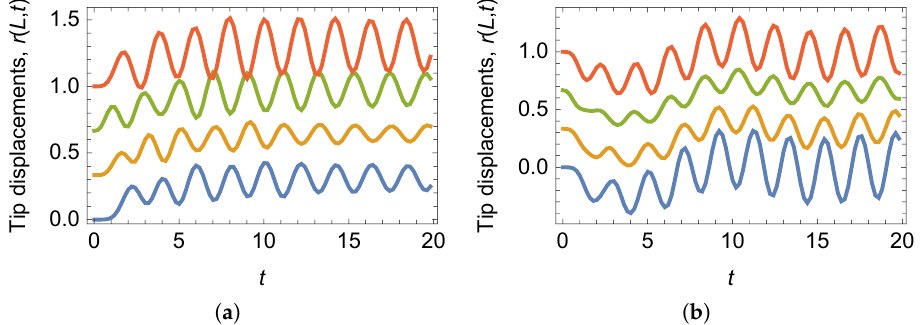
Figure 4. Evolution of the tip displacement: ( a ) rotation coupling and ( b ) curvature coupling. The response of the actuated filament is the one in